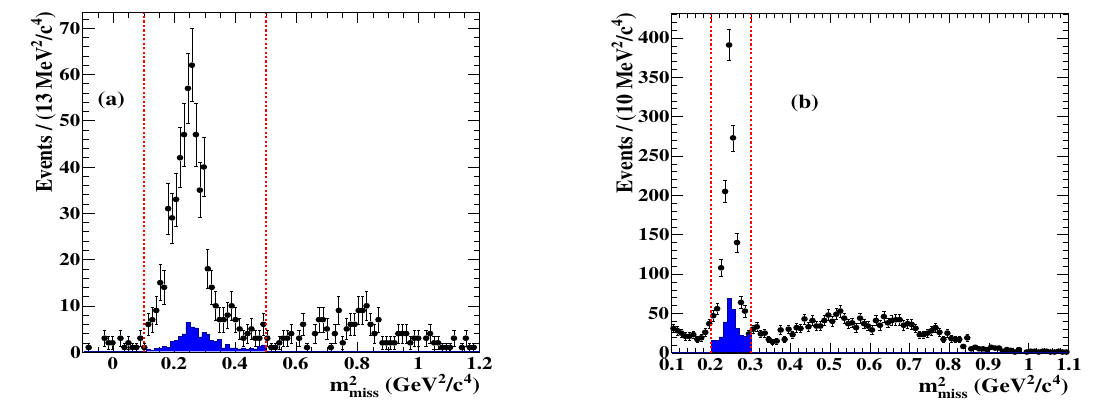
Figure 4 . m 2 distributions for D ! K 0 (cid:25) + (cid:25) (cid:0) (cid:25) 0 decays tagged by (a) CP -even states involving miss S a K 0 meson and (b) K 0 (cid:25) + (cid:25) (cid:0) . The shaded histogram shows the estimated peaking background L L and the vertical dotted lines indicate the signal region.